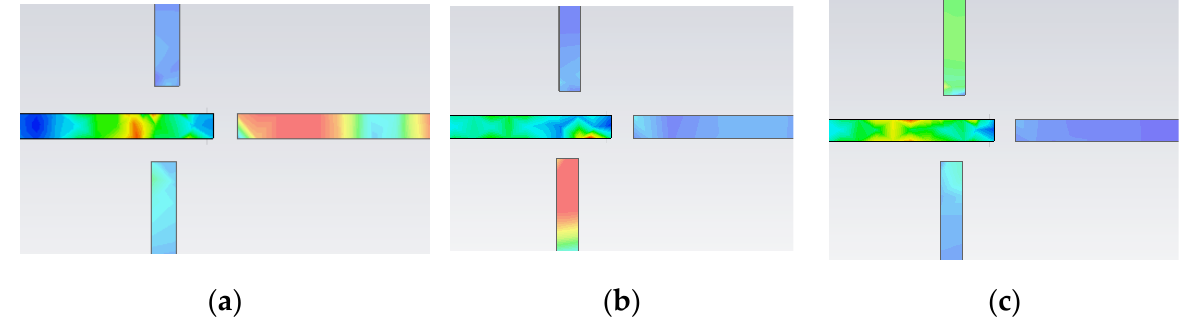
Figure 26. Surface current at ( a ) f 0 = 6.44 GHz, ( b ) f 1 = 4.79 GHz, and ( c ) f 2 = 5.6 GHz.